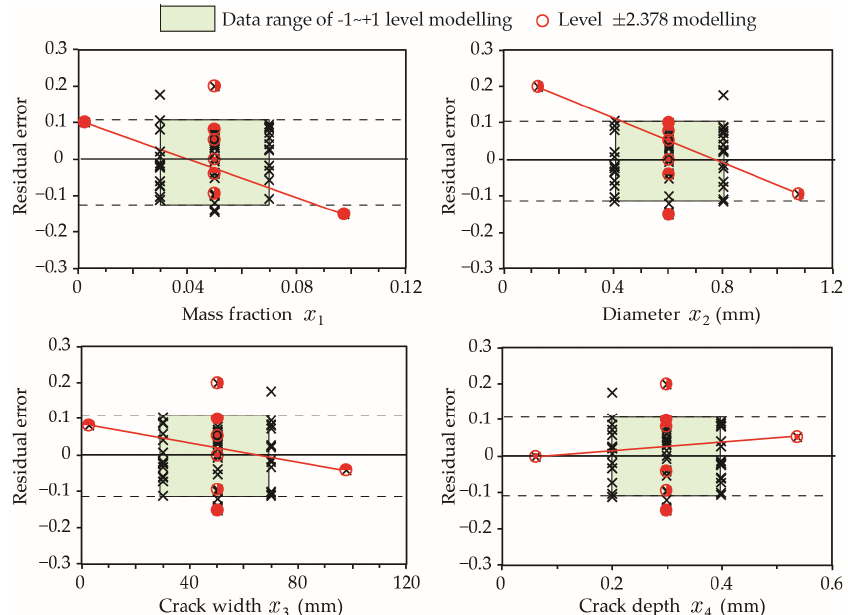
Figure 10. Influence of individual factors on residual errors of model-H 0 . The results of extreme cases at Level ±2.378 are connected by a red line.